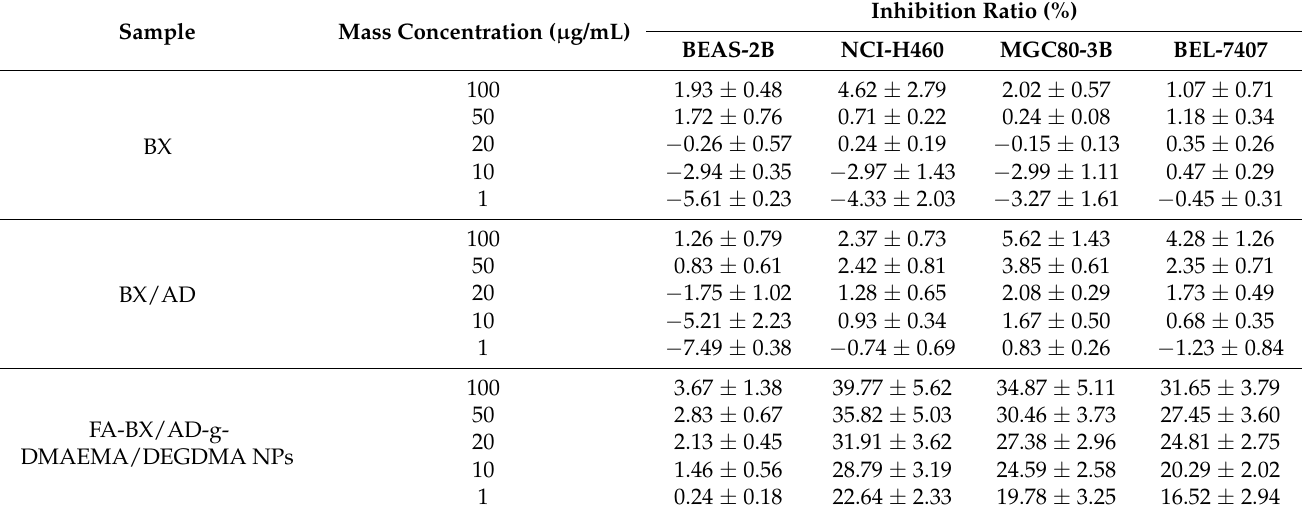
Table 2. The inhibition ratio of BX, BX/AD and FA-BX/AD-g-DMAEMA/DEGDMA NPs on different cancer cells and normal